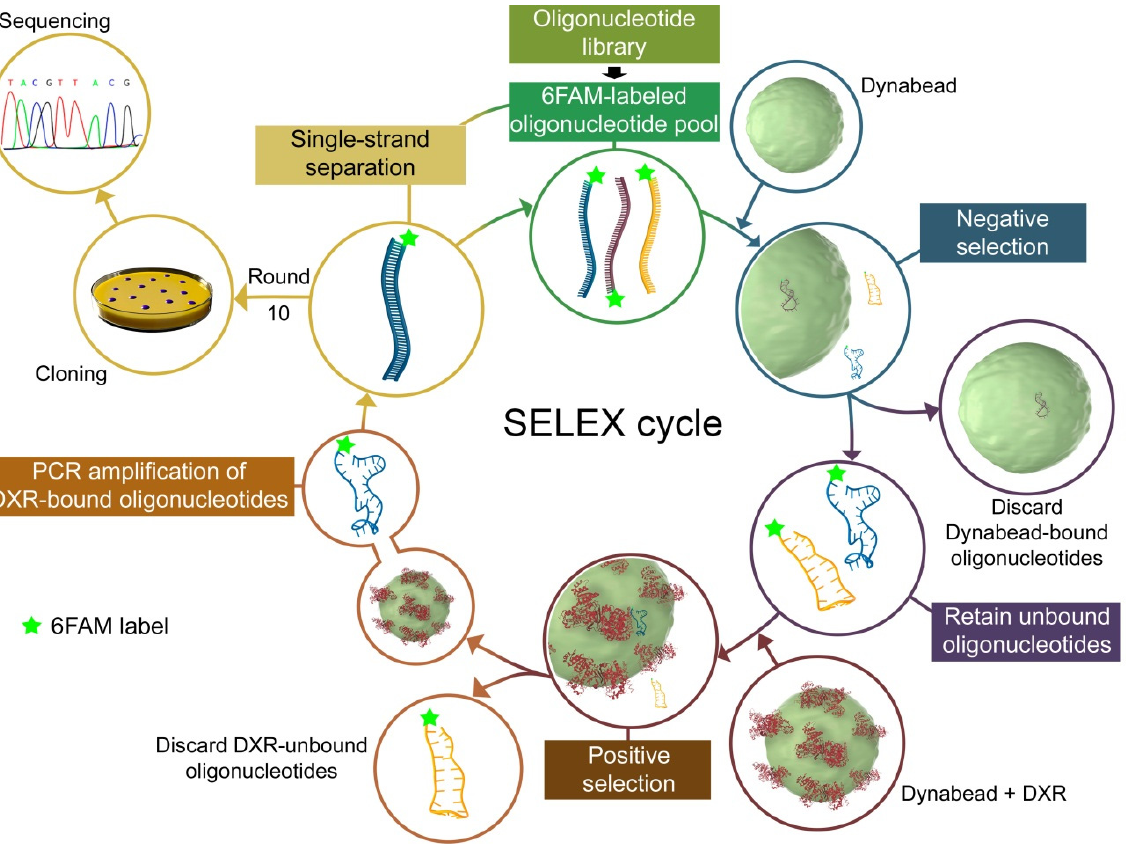
Figure 2. Scheme of the SELEX process used in this work to obtain DNA aptamers against Pf